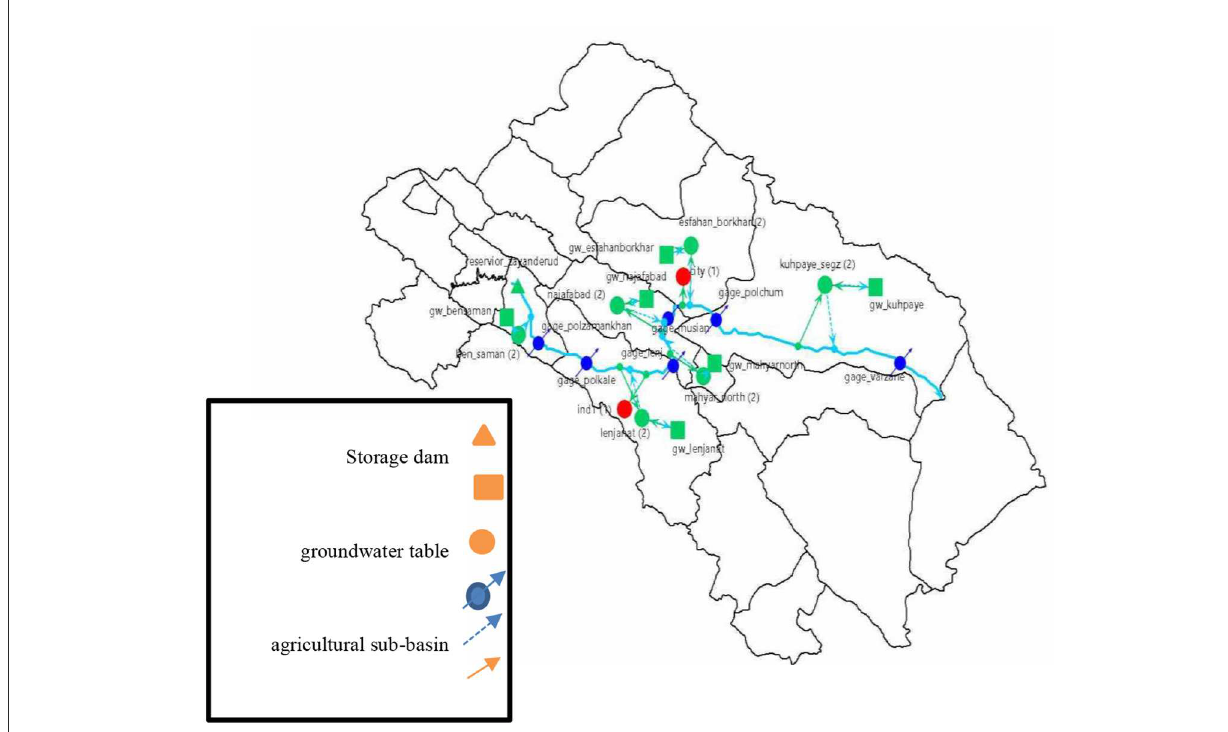
FIGURE3 The network of nodes and inflows and outflows within the study site of the Zayanderud River in WEAP software.